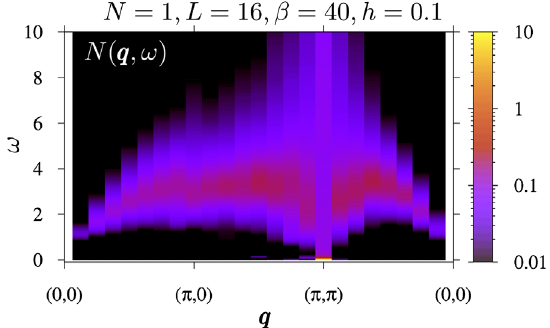
FIG. 7. Dynamical charge structure factor for the N ¼ 1